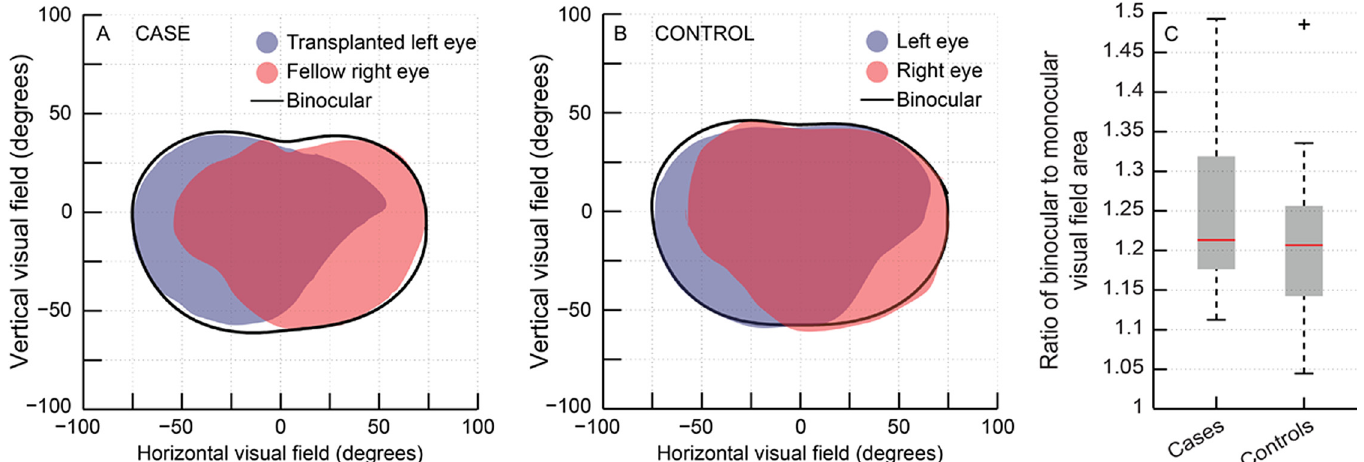
Fig 2. Binocular and monocular visual field of a representative case (panel A) and control (panel B) who participated in this study. Ratio of binocular to monocular visual field area in cases and controls (panel C). Details of Box and Whisker plot same as Fig 1.